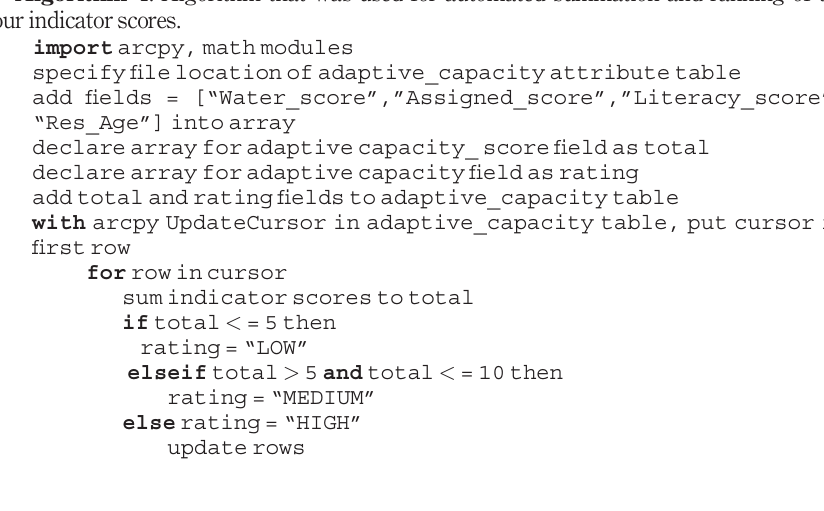
Algorithm 4 . Algorithm that was used for automated summation and ranking of the four indicator scores. import arcpy, math